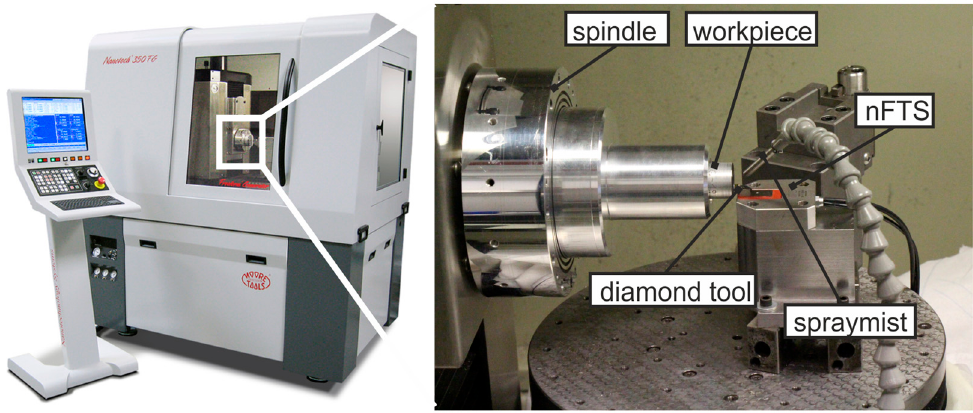
Figure 2. Nanotech 350 FG ultra precision turning lathe and experimental setup.